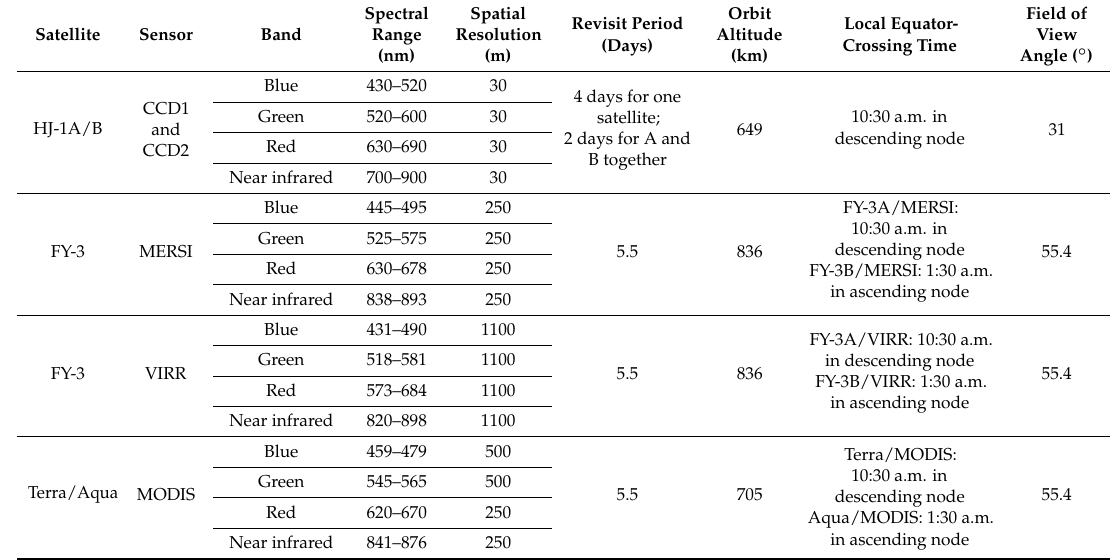
Table 1. The primary characteristics of participating bands of CCDs, MERSIs and